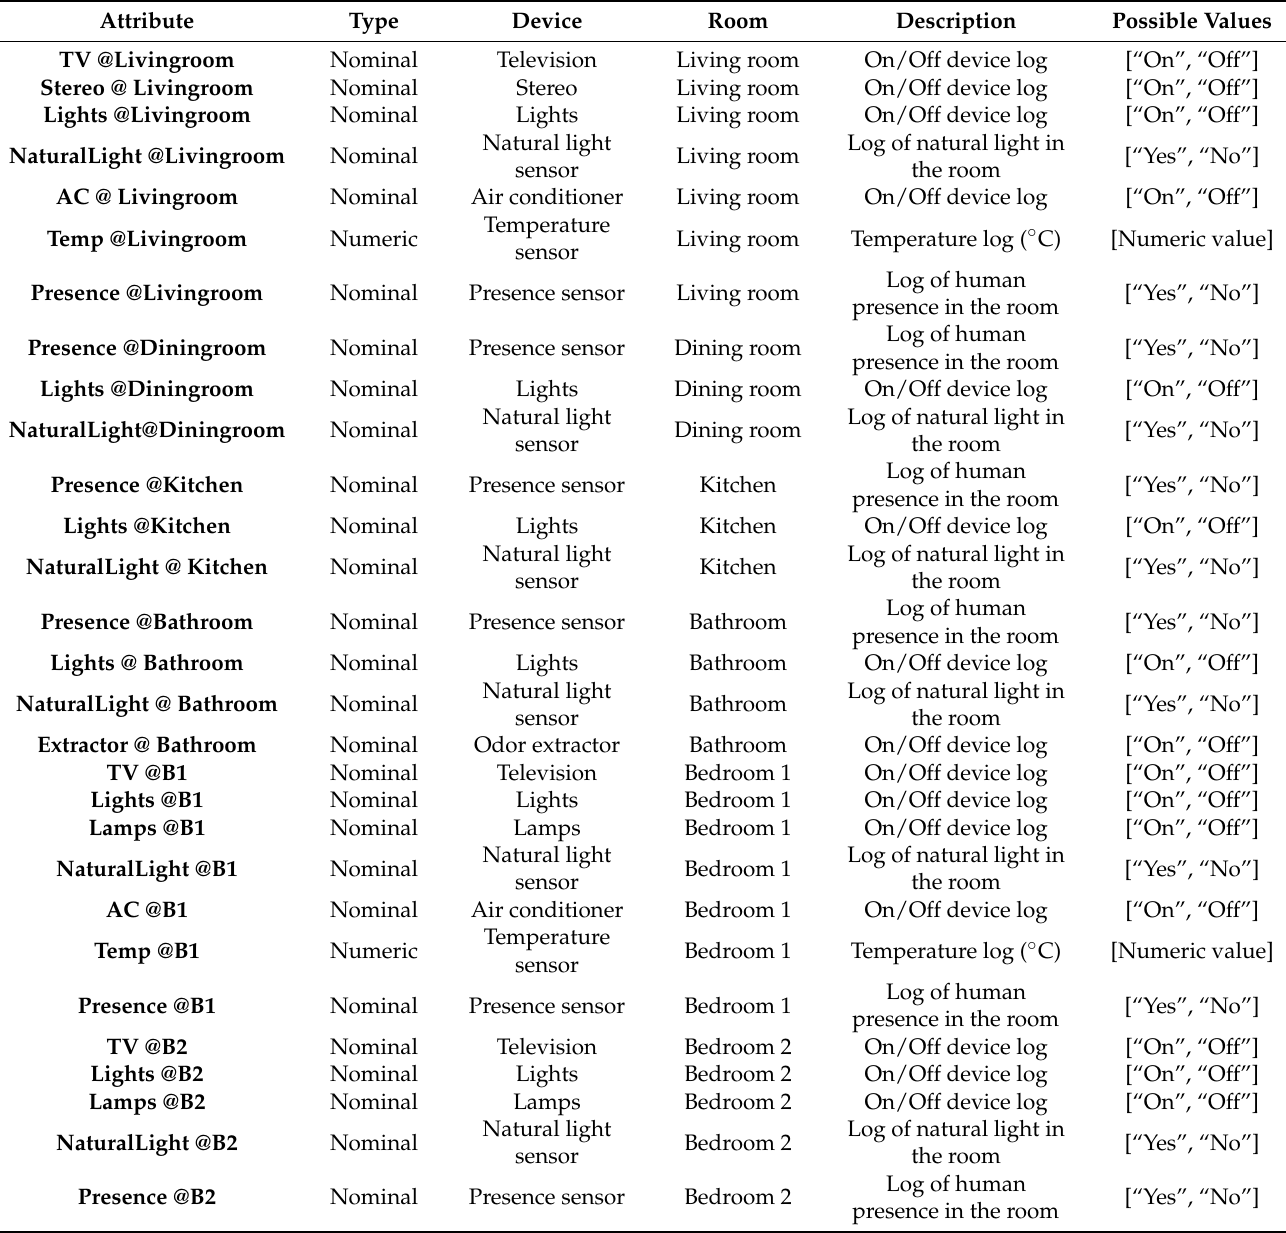
Table 3. Attributes considered for the C4.5